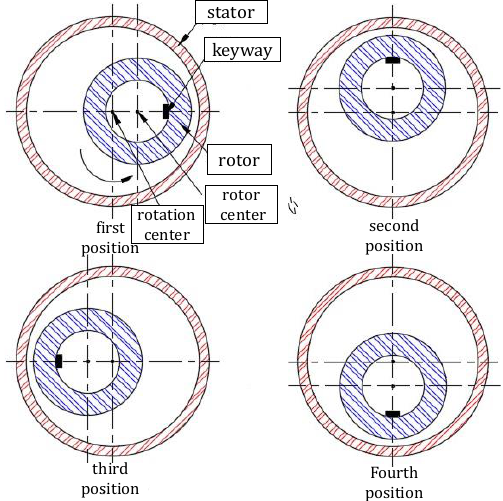
Figure 1. Diagram of the dynamic eccentric motion of the rotor.